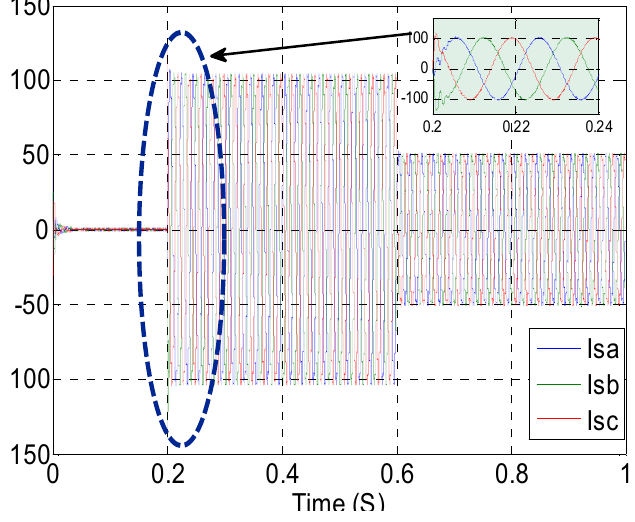
Figure 19. Stator three-phase currents (A).